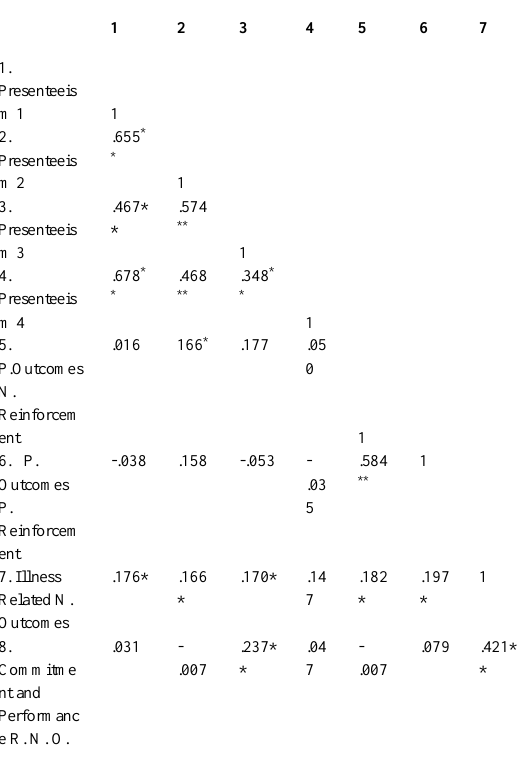
Table 18: Correlations among Different Measures of Presenteeism and Outcomes